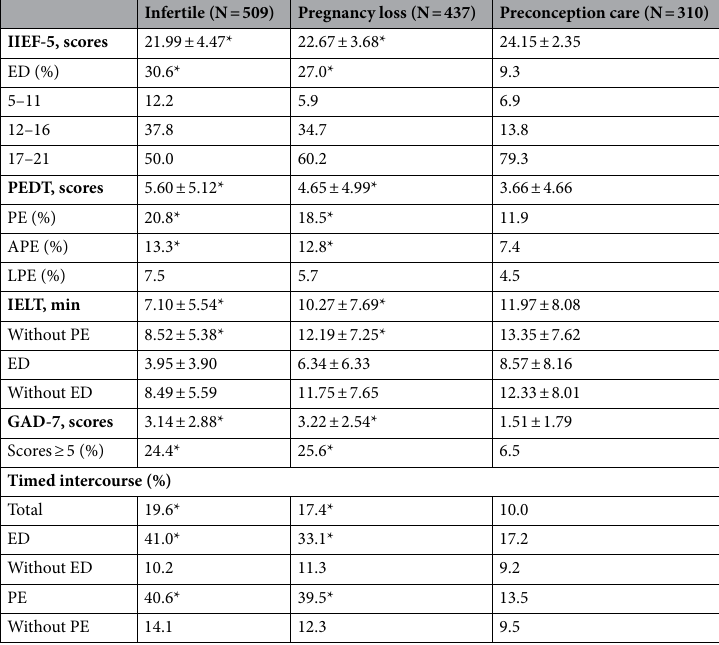
Table 2. Sexual dysfunction, Sexual features, and anxiety among the subjects studied. Datas were expressed as mean ± standard deviation or percentage, when appropriate. PL pregnancy loss, PC preconception care, PE premature ejaculation, APE acquired premature ejaculation, LPE lifelong premature ejaculation, ED erectile dysfunction, GAD-7 7-item Generalized Anxiety Disorder Scale, PEDT premature ejaculatory diagnostic tool, IIEF-5 International Index of Erectile Function, TI timed (around the time of ovulation) intercourse, IELT intravaginal ejaculatory latency time. *p < 0.05 as compared with preconception care group.